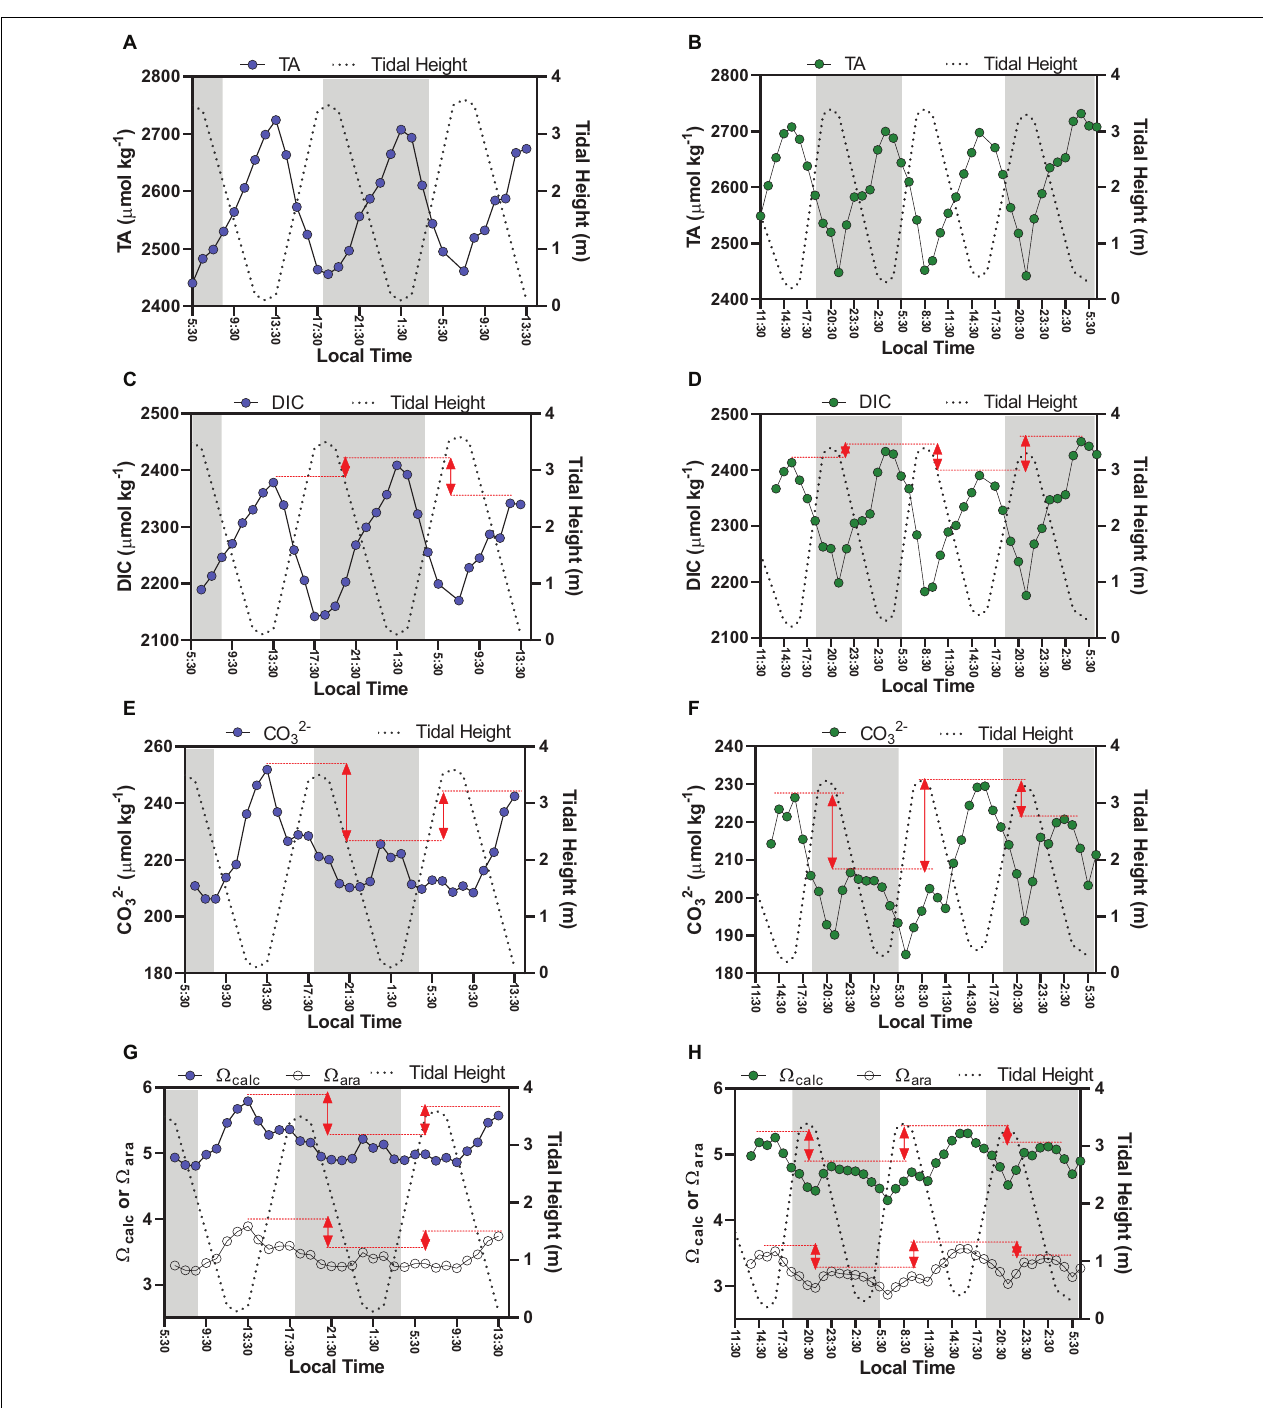
FIGURE 2 | Time-series observations of carbonate chemistry parameters sampled hourly (discrete sampling), which are TA (A,B) , DIC (C,D) , CO 32 − (E,F) , (cid:127) calc , and (cid:127) ara (G,H) . Graphs on the left side represent Oct-2017 (blue dots); graphs on the right side represent Sep-2018 (green dots). The red lines in graphs illustrate the diel variability by comparing minimal tidal heights occurring at different hours of the day (daytime × night-time).